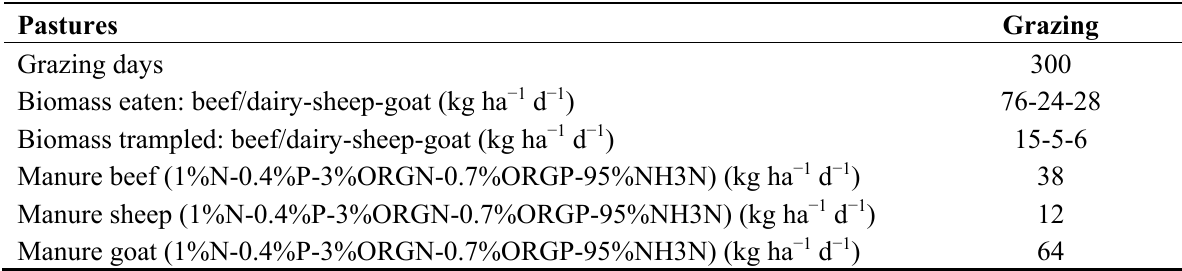
Table 2. Management operations considered for pastures in the Donga-Pont catchment. NH3N is the dissolved nitrogen, easily convertible into nitrate. Pastures